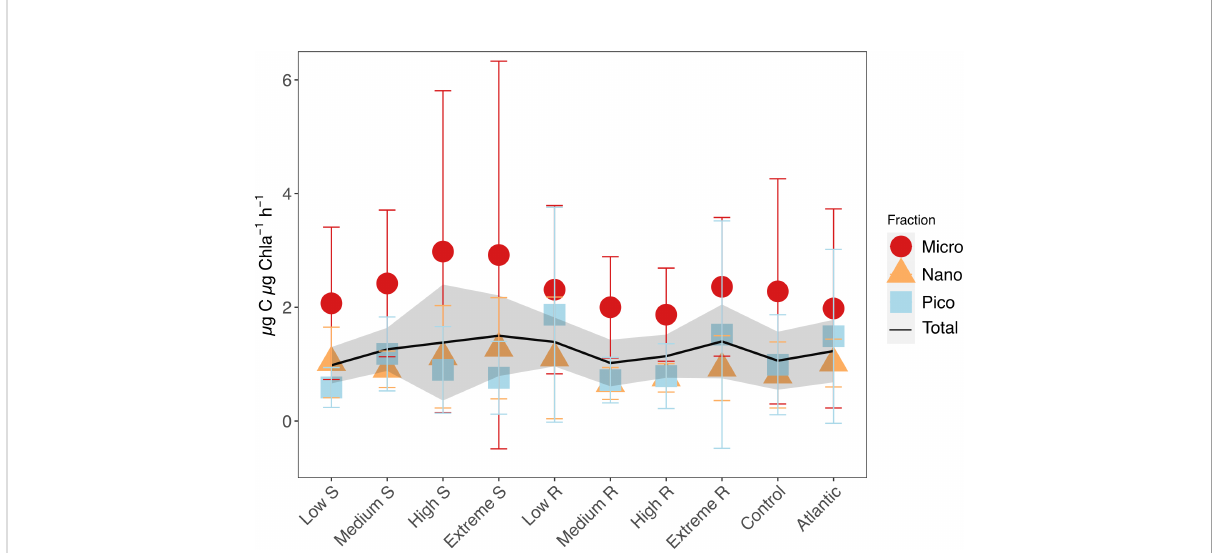
FIGURE 6 Mean carbon assimilation numbers (AN) and standard deviations for total phytoplankton, microphytoplankton (20-250 µm), nanophytoplankton (2-20 µm) and picophytoplankton (0.2-2 µm). Shaded area shows standard deviation for total phytoplankton